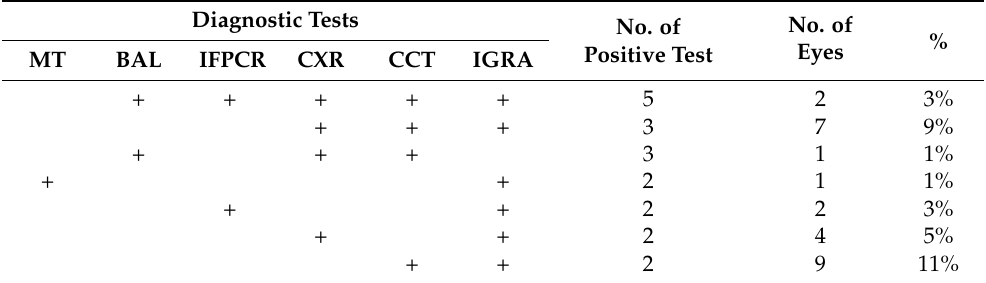
Table 2. Patterns of positive diagnostic tests among